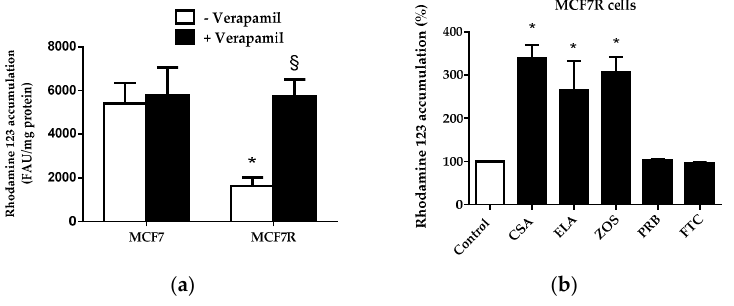
Figure 2. Accumulation of rhodamine 123 in MCF7 and MCF7R cells. ( a ) Cells were exposed to 5.25 μ M rhodamine 123 for 30 min at 37 °C in the absence or presence of 50 μ M verapamil. After washing, rhodamine 123 accumulation was quantified by spectrofluorimetry. Data are expressed as fluorescence arbitrary unit (FAU)/mg protein and are the means ± SEM of three independent experiments. *, p < 0.05 when compared to MCF7 cells; §, p < 0.05 when compared to counterparts not exposed to verapamil. ( b ) MCF7R cells were exposed to 5.25 μ M rhodamine 123 for 30 min at 37 °C in the absence (control) or presence of 100 μ M cyclosporin A (CSA), 1 μ M elacridar (ELA), 1 μ M zosuquidar (ZOS), 2 mM probenecid (PRB) or 10 μ M fumitremorgin C (FTC). After washing, cellular rhodamine 123 accumulation was quantified by spectrofluorimetry. Data are expressed as % of fluorescent dye accumulation in control MCF7R cells exposed only to rhodamine 123, arbitrarily set at 100%, and are the means ± SEM of three independent assays. *, p < 0.05 when compared to control cells.